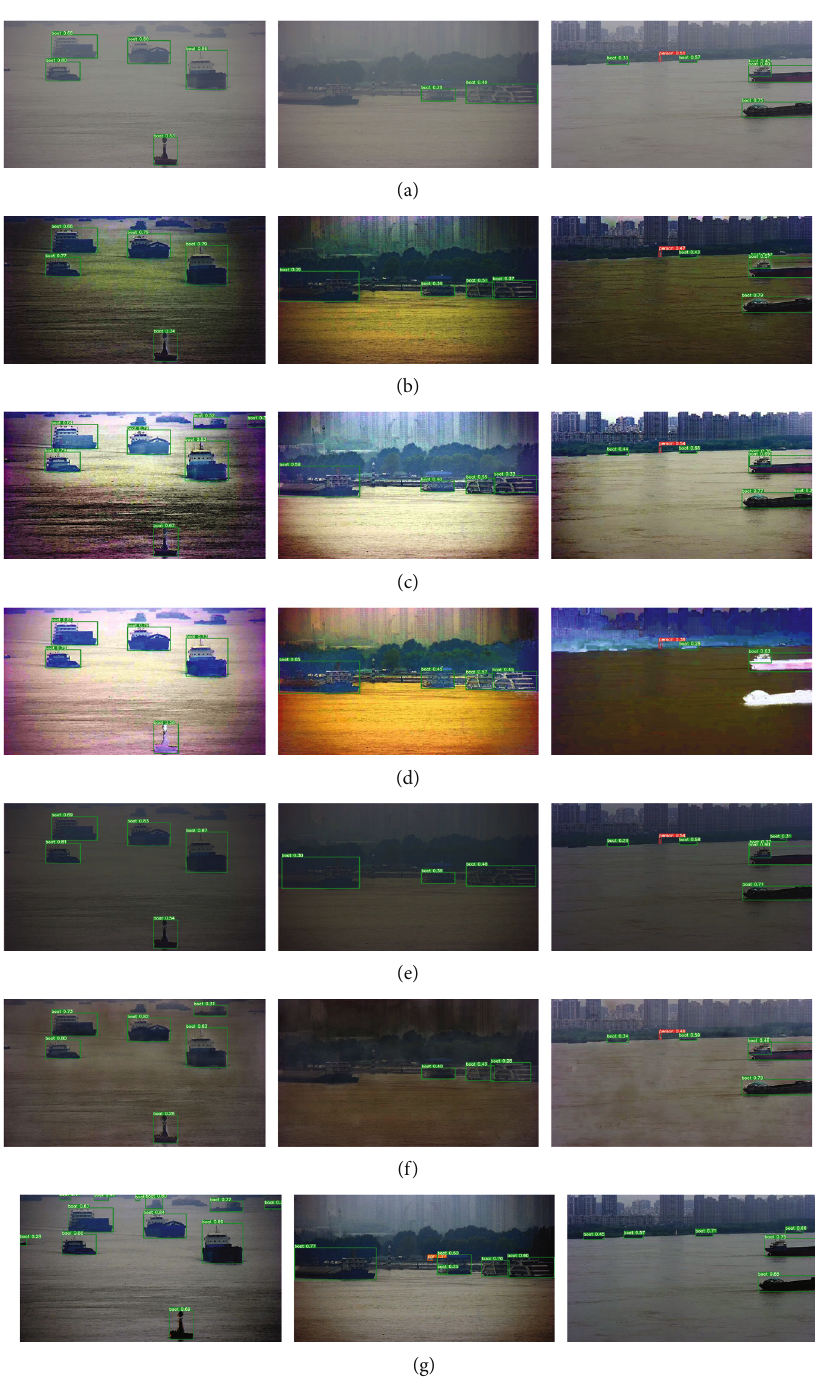
Figure 12: Examples of detection results on the dehazed real-world hazy images. From top to bottom: (a) real hazy images and restored images, generated by (b) DCP [19], (c) nonlocal [37], (d) F-LDCP [20], (e) AODNet [25], (f) GCANet [26], and (g) ours,